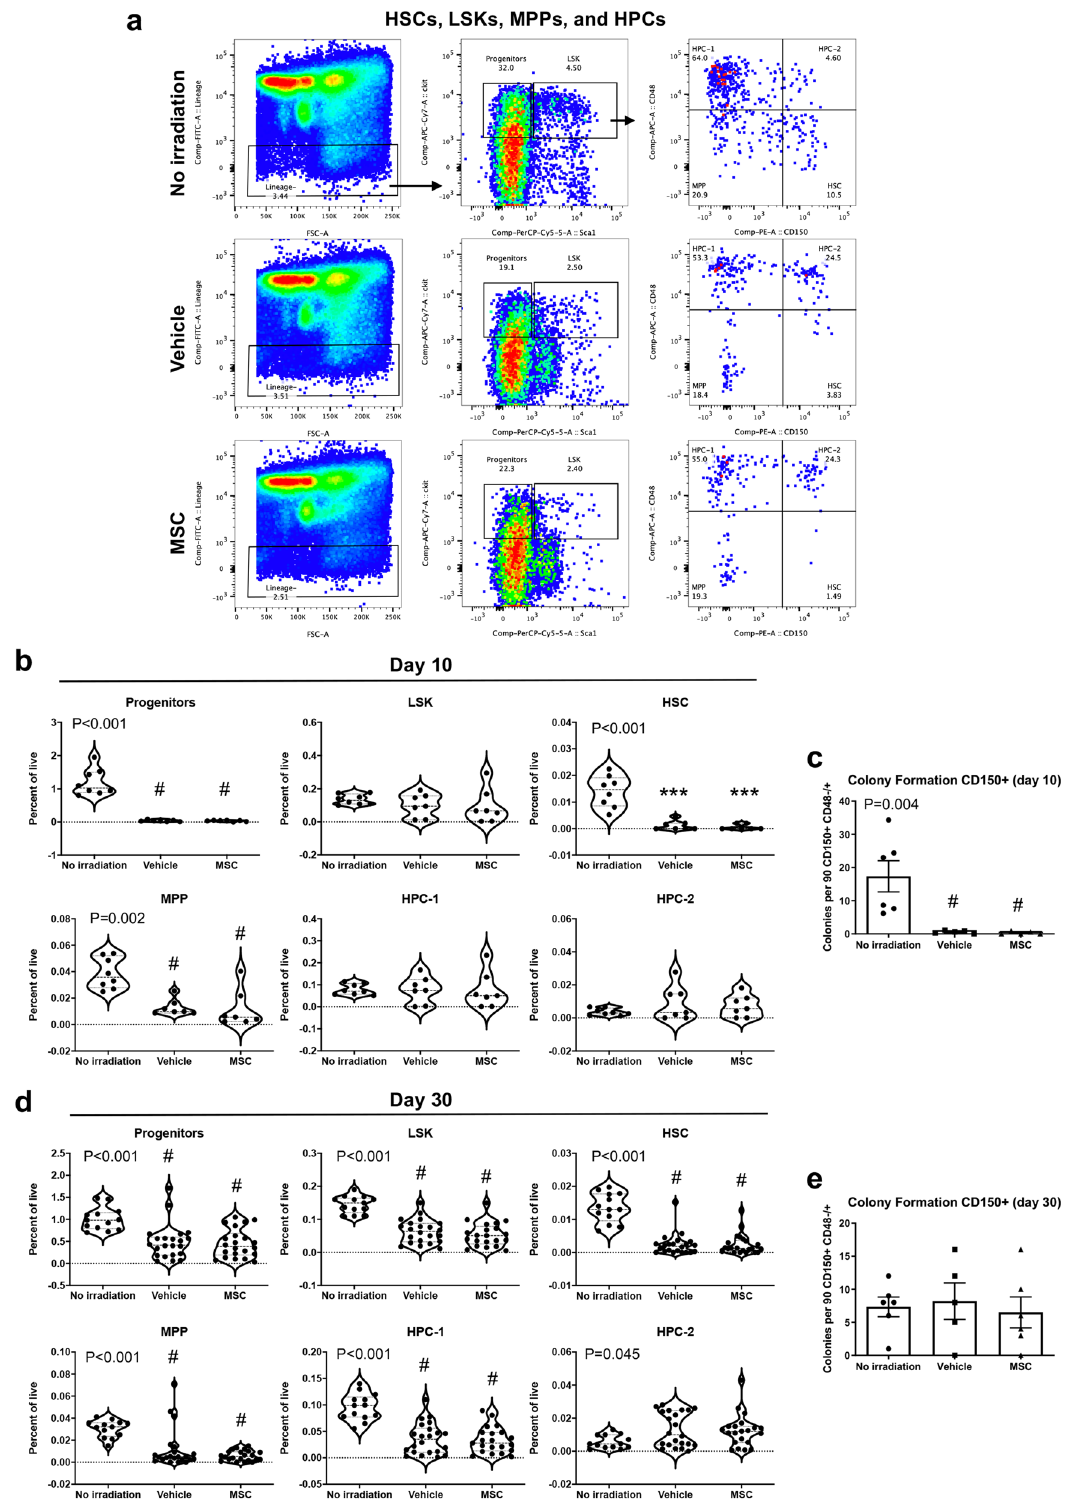
Figure 4. MSC therapy fails to promote recovery of hematopoietic stem and progenitor cells. ( a ) Frequencies of HSCs, LSK, HPC-1, HPC-2, MPP, and progenitors were determined by the depicted gating strategies. ( b , d ) Frequencies of hematopoietic subsets are equivalent in vehicle and MSC recipients. ( c , e ) CFU activity of sorted CD150 + cells. Statistical significance of differences between groups is depicted on the graphs. Posthoc comparisons are demarcated by asterisks *** P < 0.001 for Holm–Sidak (One-way ANOVA) or pound symbol # P < 0.5 for Dunn’s (Kruskal–Wallis One-way ANOVA) analyses relative to No irradiation